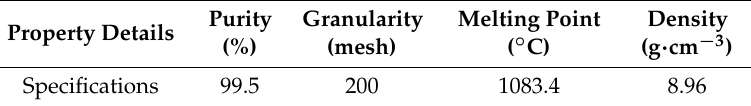
Table 4. Details of Cu used in brake composites.